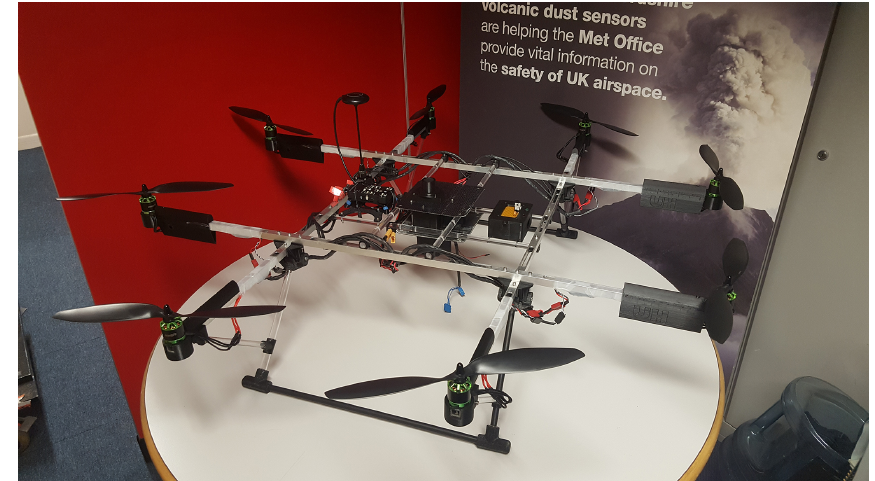
Figure 1. The University of Hertfordshire aerosol-sampling SUA (UH-AeroSAM). This is a bespoke SUA specifically designed to sample aerosol particles and droplets using a custom-built OPC.